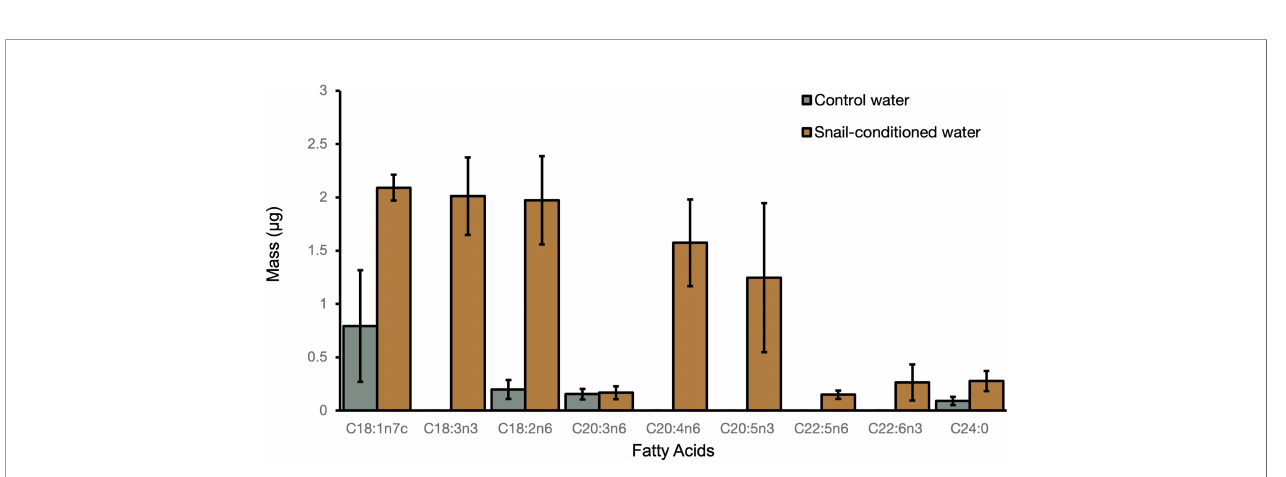
FIGURE 4 | Mean mass of fatty acids ( ± SE) detected in both control and snail-conditioned water over three